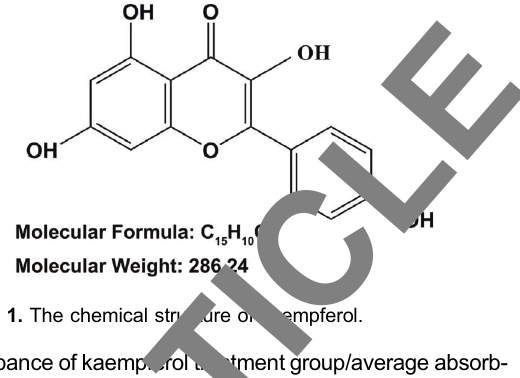
Figure 1. The chemical structure of